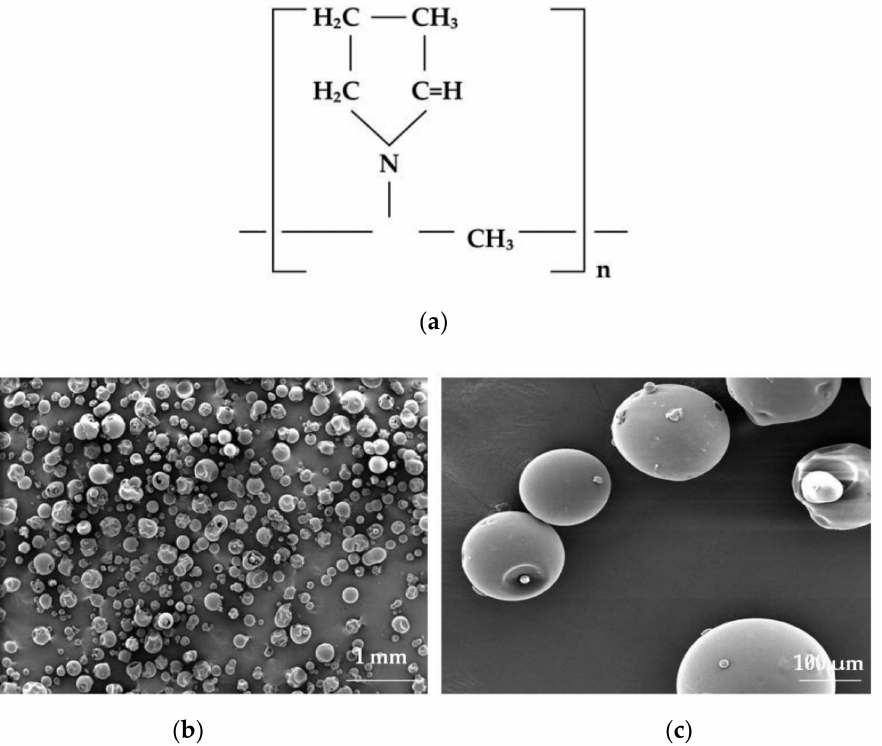
Figure 10. Chemical structure of ( a ) polyvinyl pyrrolidone and SEM picture of polyvinyl pyrroli- done 40 powder under magnification ( b ) 100 × , ( c ) 1000 × (photographs of the authors made with Inspect™S50, FEI Company, Hillsboro, OR,